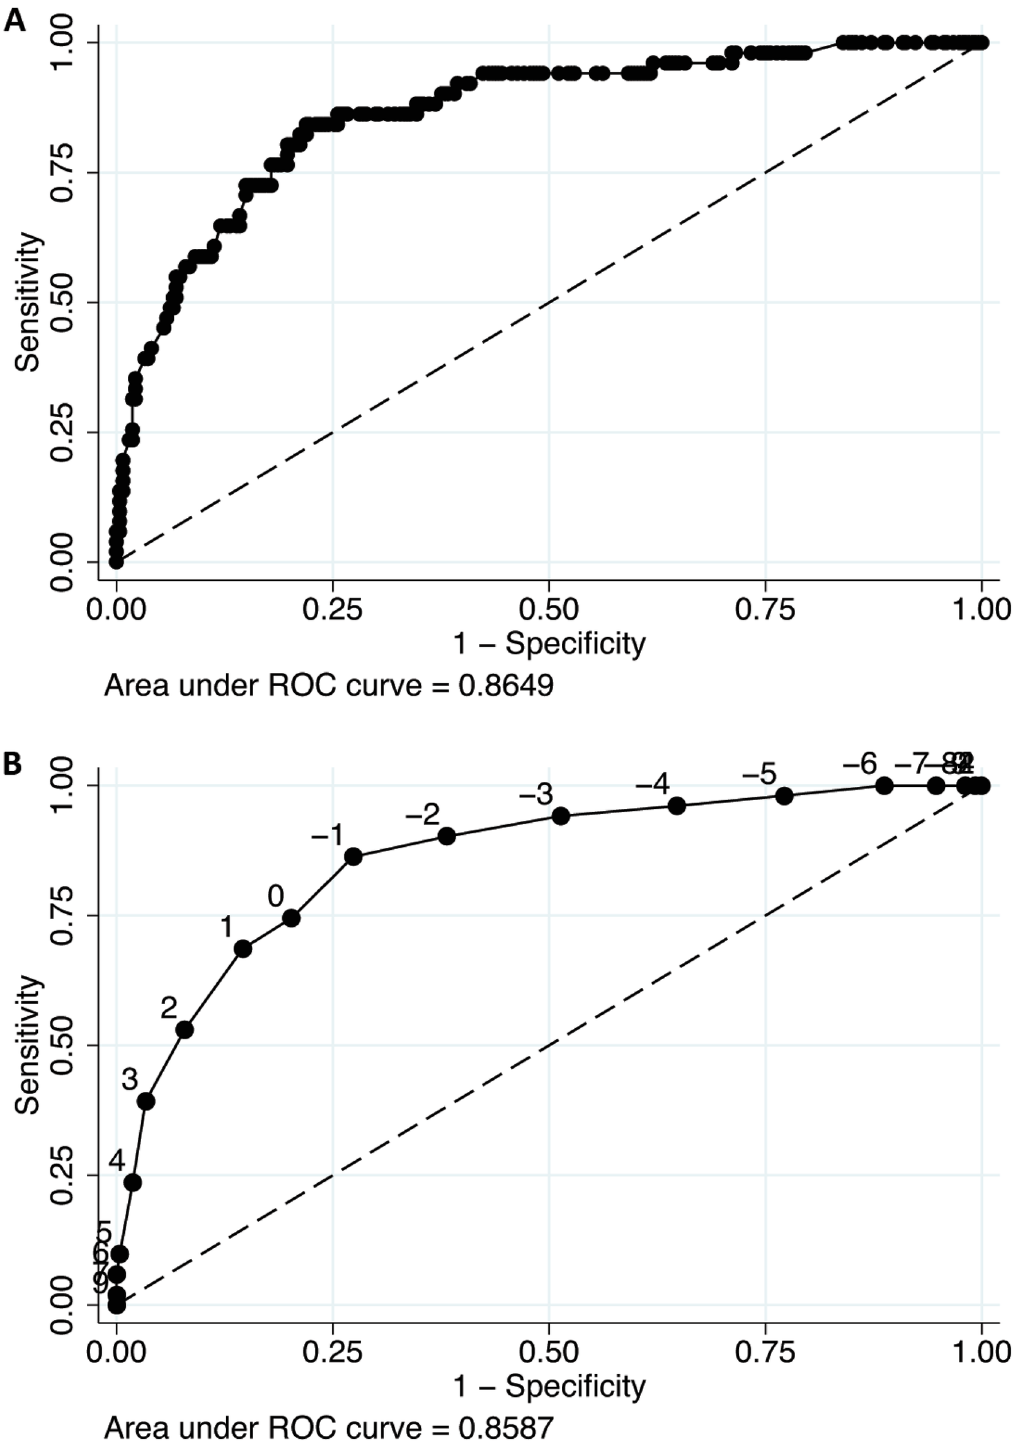
Fig 2. ROC curve of multivariable prediction model (A) and Buruli score (B).